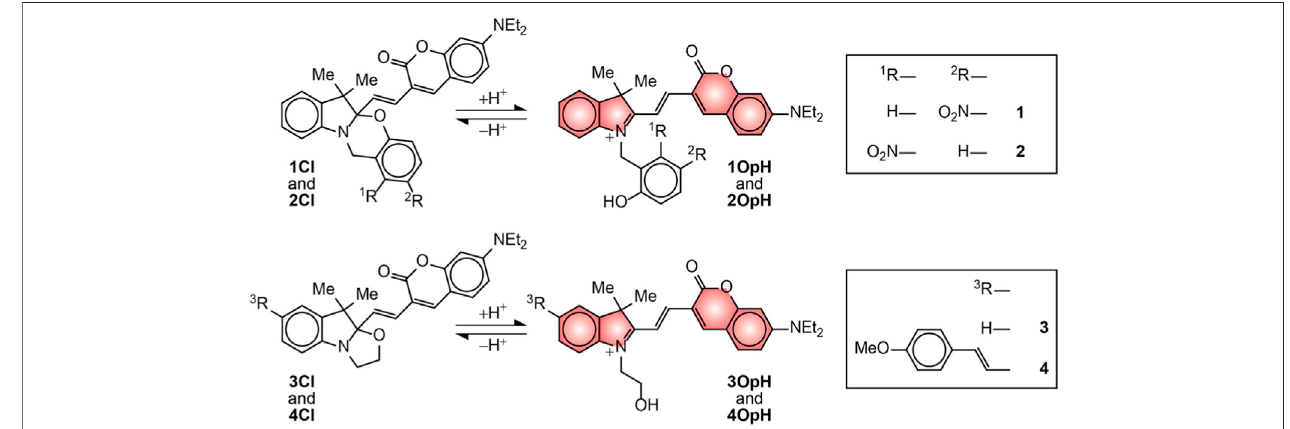
FIGURE 1 | Interconversion of the ring-closed (Cl) and protonated ring-open (OpH) forms of 1 – 4 .